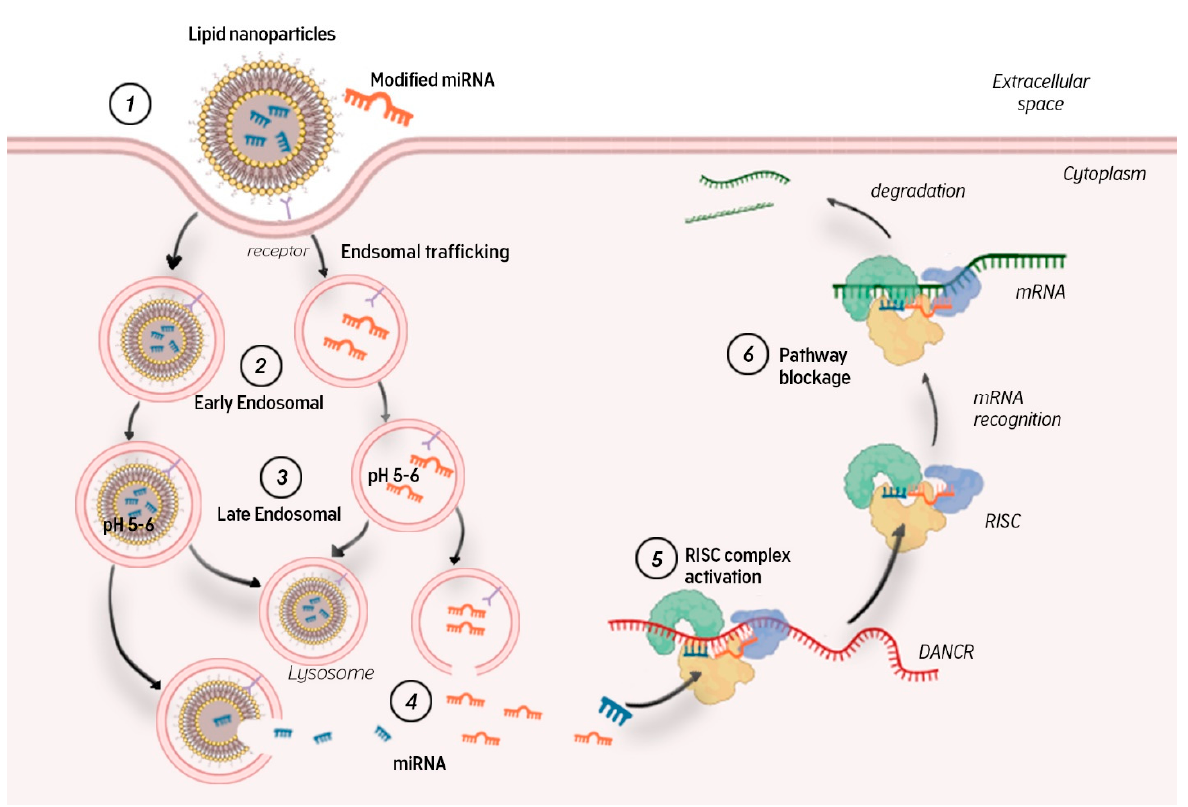
Figure 3. Transport of microRNA inside the cell (description in the article).